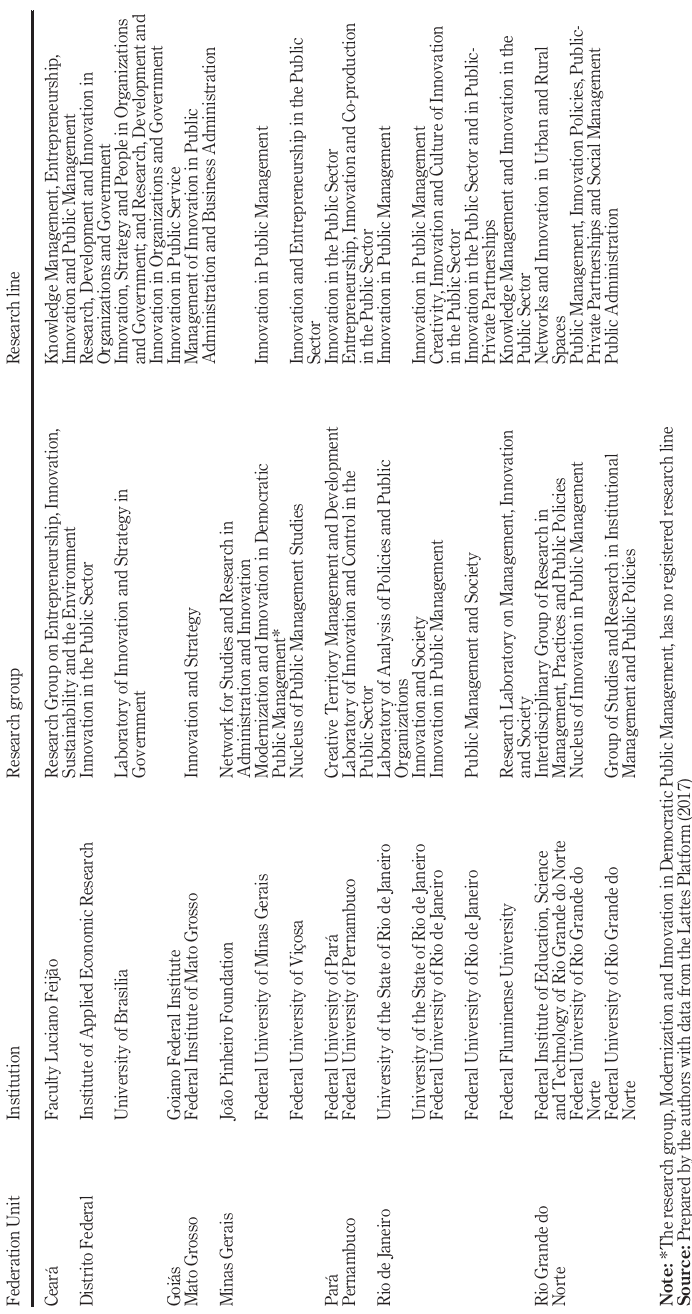
Table V. Distribution of research groups on innovation in the public sector by federation unit and